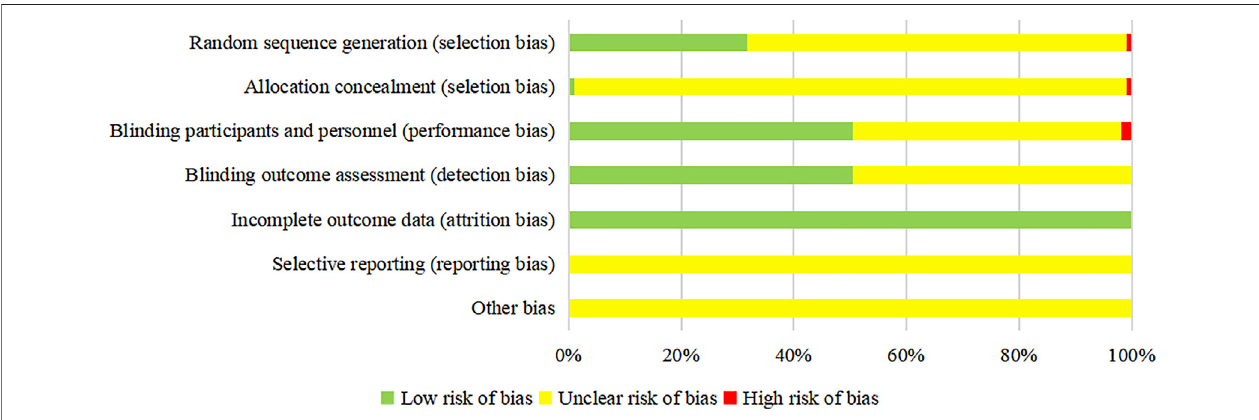
FIGURE 3 | Risk of bias graph of the included RCTs. The vertical axis represents the risk of bias items, and the horizontal axis represents the percentage of the number of RCTs. For the outcome whose evaluation process is objective, the “ unclear risk of bias ” should be regarded as “ low risk of bias ” .